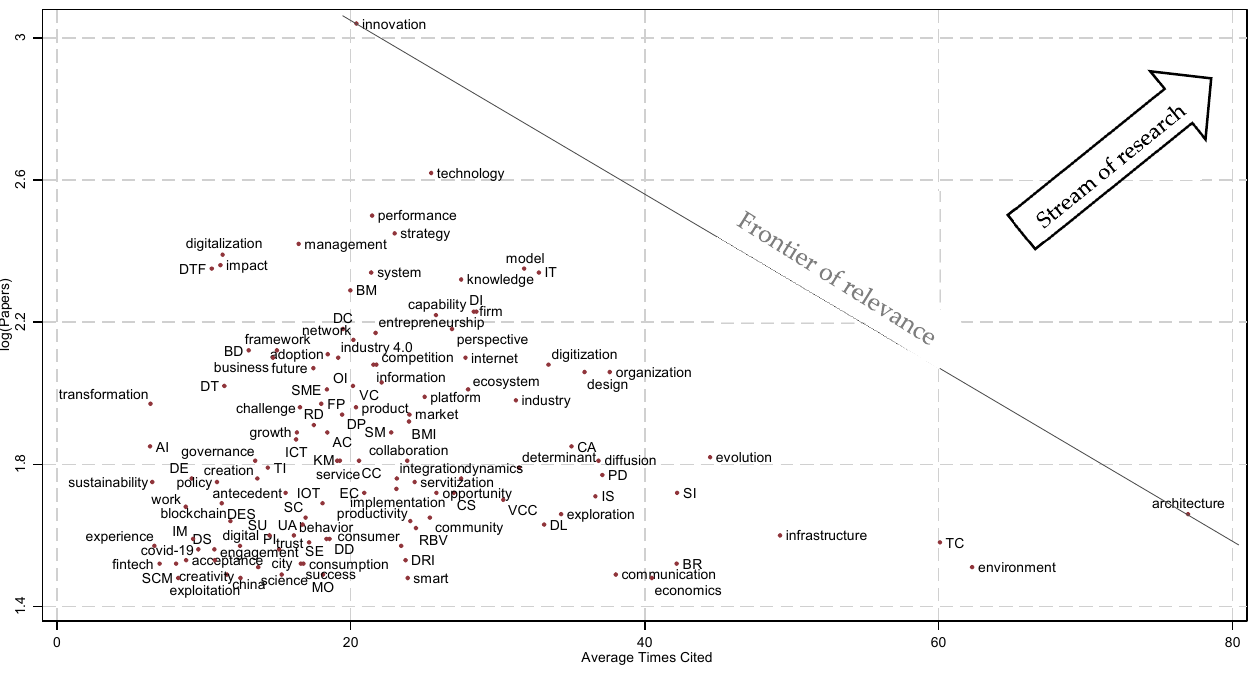
Figure 6. Analysis of streams of research on the most prominent keywords.